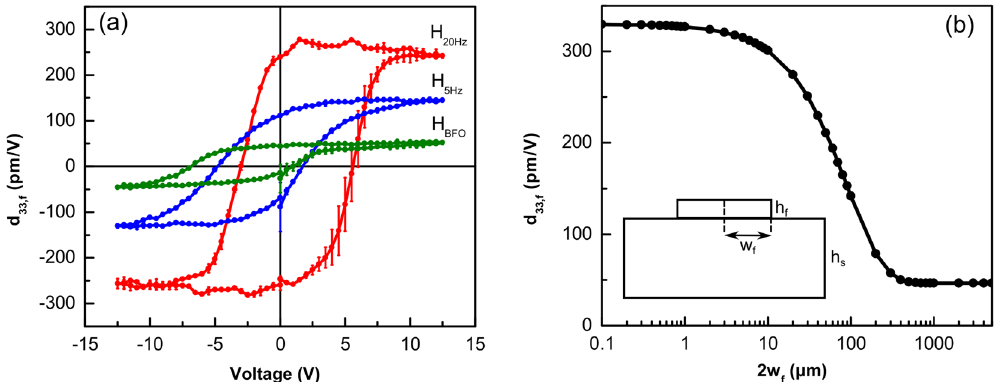
Figure 5. Piezoelectric response. ( a ) Longitudinal piezoelectric response ( d 33,f ) of the three heterostructures measured using a laser Doppler vibrometer. Error bars represent the standard deviation. ( b ) Reduction of the piezoelectric response with increasing island